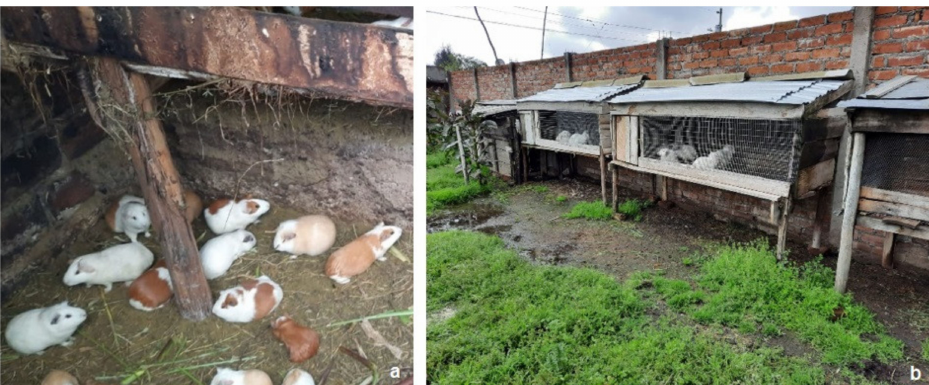
Figure 5. ( a ) Guinea pigs raised inside the house; ( b ) rabbits in aerial